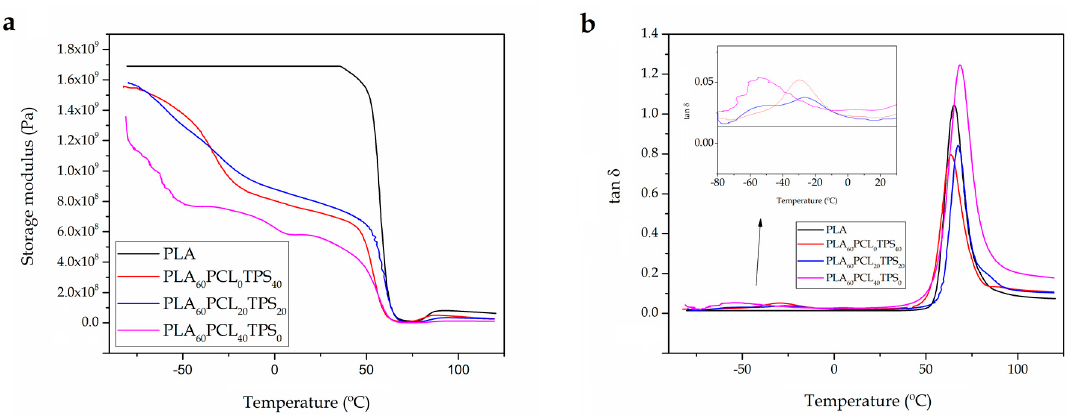
Figure 7. Comparative plot of the polylactide (PLA), poly( ε -caprolactone) (PCL), and thermoplastic starch (TPS) blend pieces in terms of: ( a ) Storage modulus (G’) versus temperature; and ( b ) dynamic damping factor (tan δ ) versus temperature.